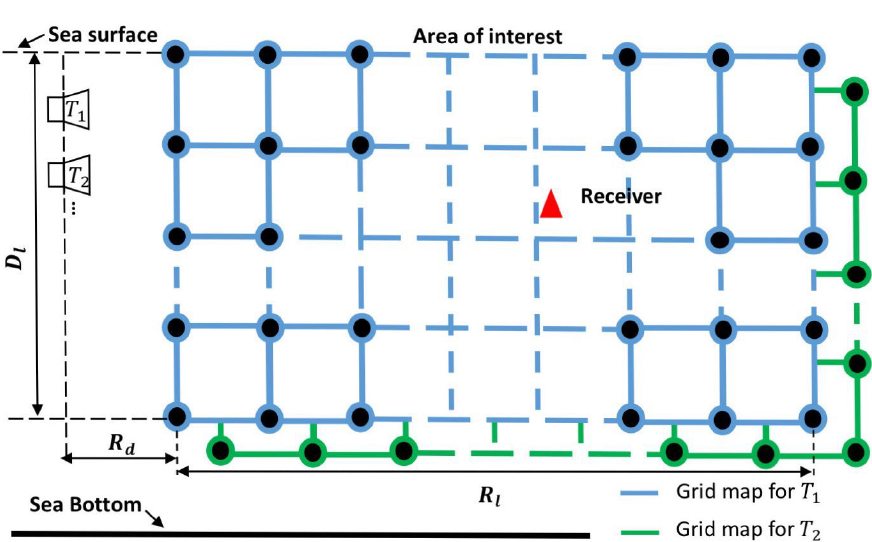
Figure 1. An example of two grid maps for a geographical area; every grid map corresponds to a specific transmit